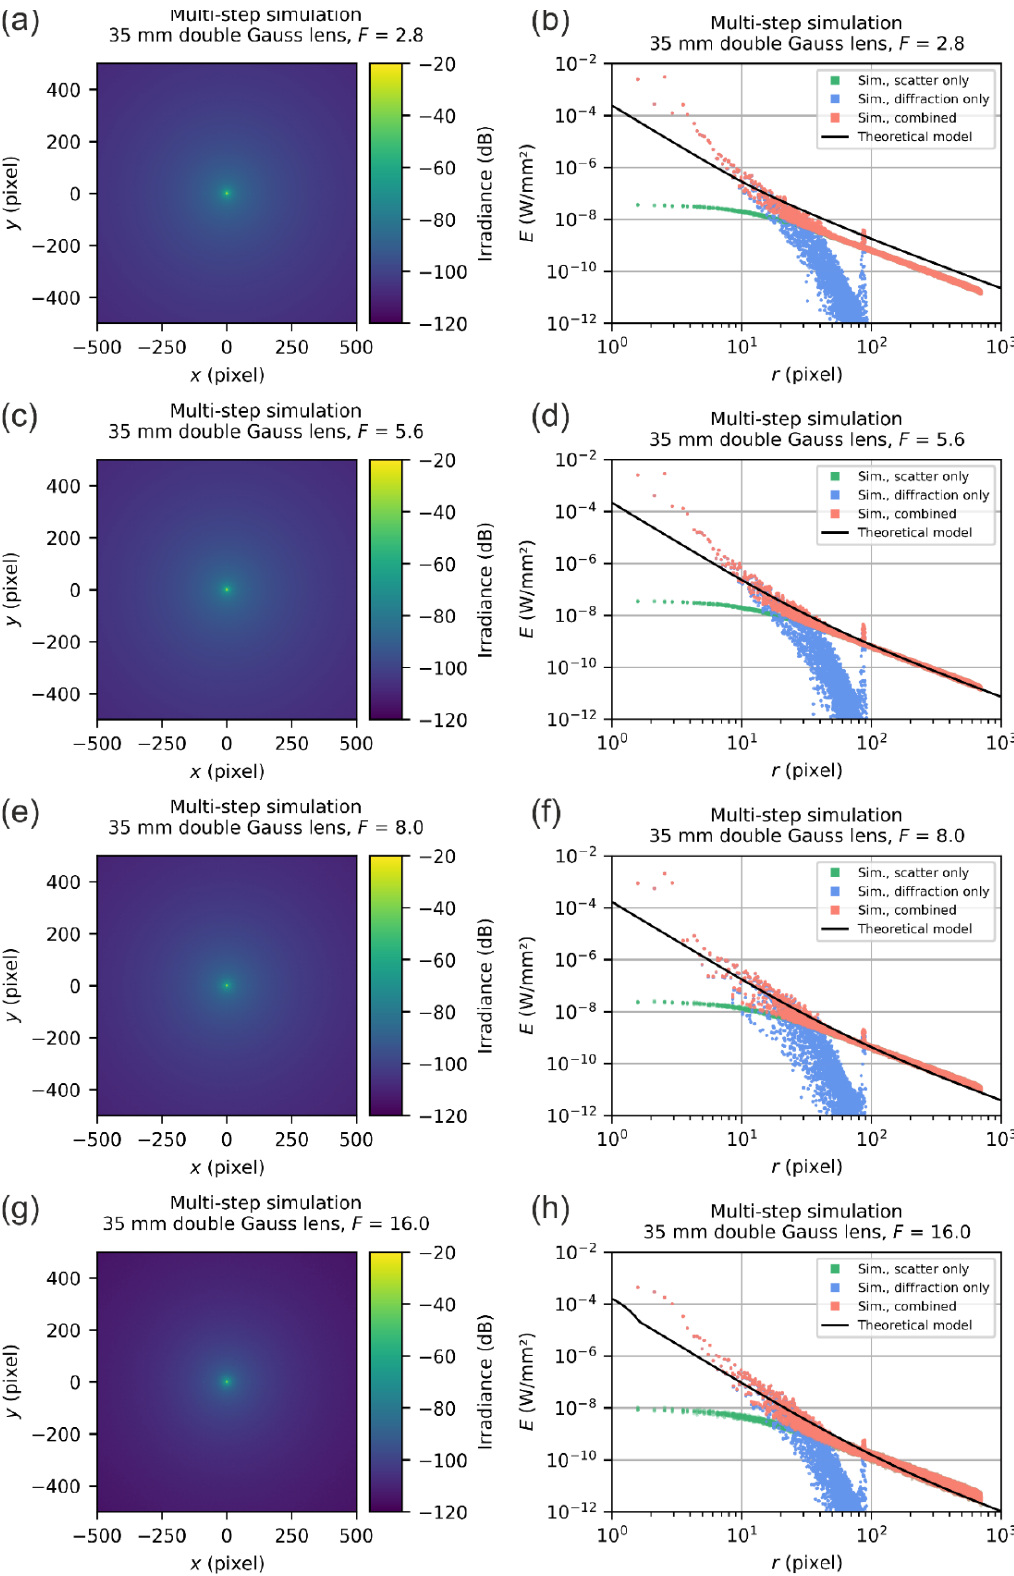
Figure 15. Results of the multi-step simulation for a 35 mm Double-Gauss lens for the f-numbers of F = 2.8, F = 5.6, F = 8.0 and F = 16.0, using our generic set of scatter parameters. ( a , c , e , g ) Results represented as an image. ( b , d , f , h ) Results shown as a scatter plot.